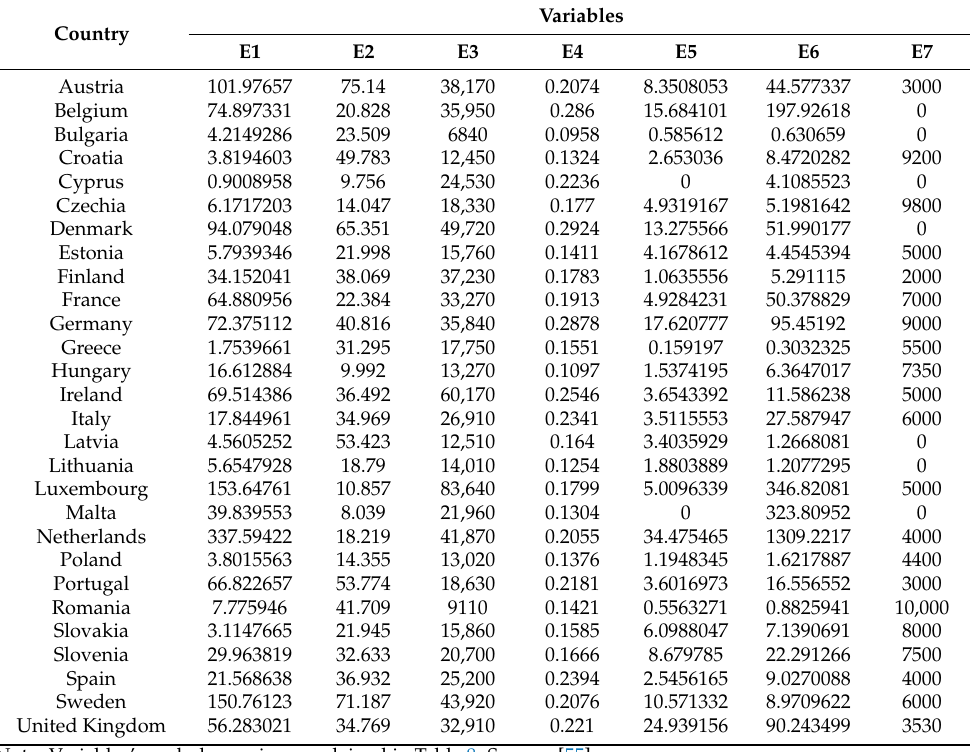
Table A1. Raw data used in the research for 28 European Union countries in